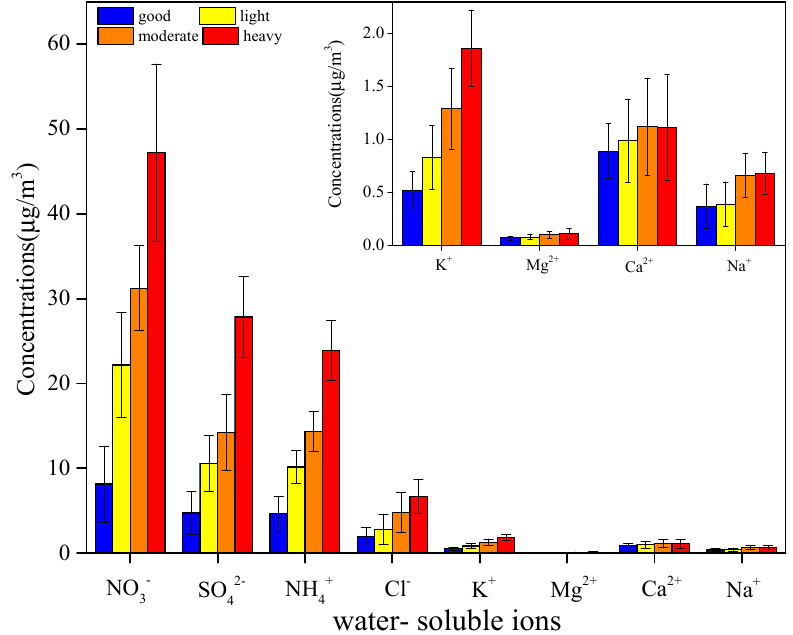
Figure 3. The concentrations of water–element compositions in four pollution days.